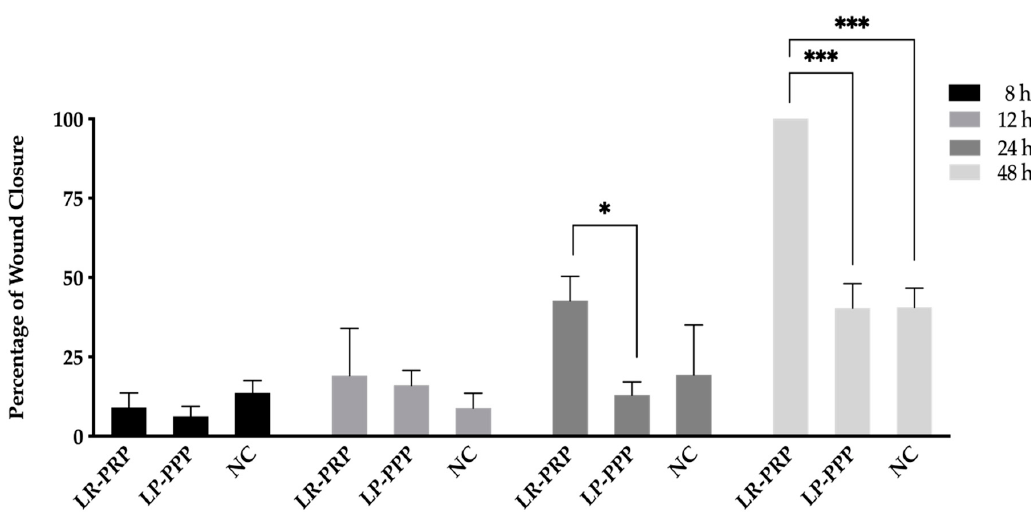
Figure 2. Scratch wound assay. Wound closure for each time point and group is measured in percentages. Data were analyzed for n = 3 samples (6 replicate wells for each sample) using the mean ± standard error of the mean (SEM) using a two-way ANOVA and Tukey’s multiple comparison tests (* p = 0.033 statistically significant difference, *** p < 0.001 very highly statistically significant difference). Abbreviations: Leucocyte-rich-platelet-rich plasma (LR-PRP), leucocyte-poor-platelet poor plasma (LP-PPP), negative control